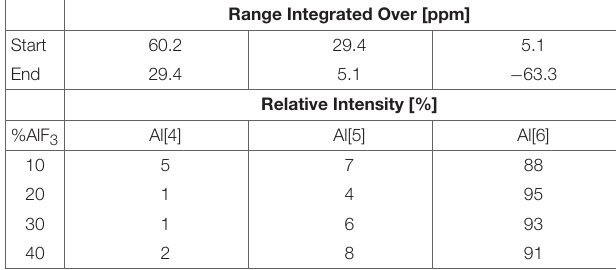
TABLE 6 | Chemical shift ranges and integration of (100- x )NaPO 3 – x AlF 3 series from 27 Al MAS NMR. Range Integrated Over